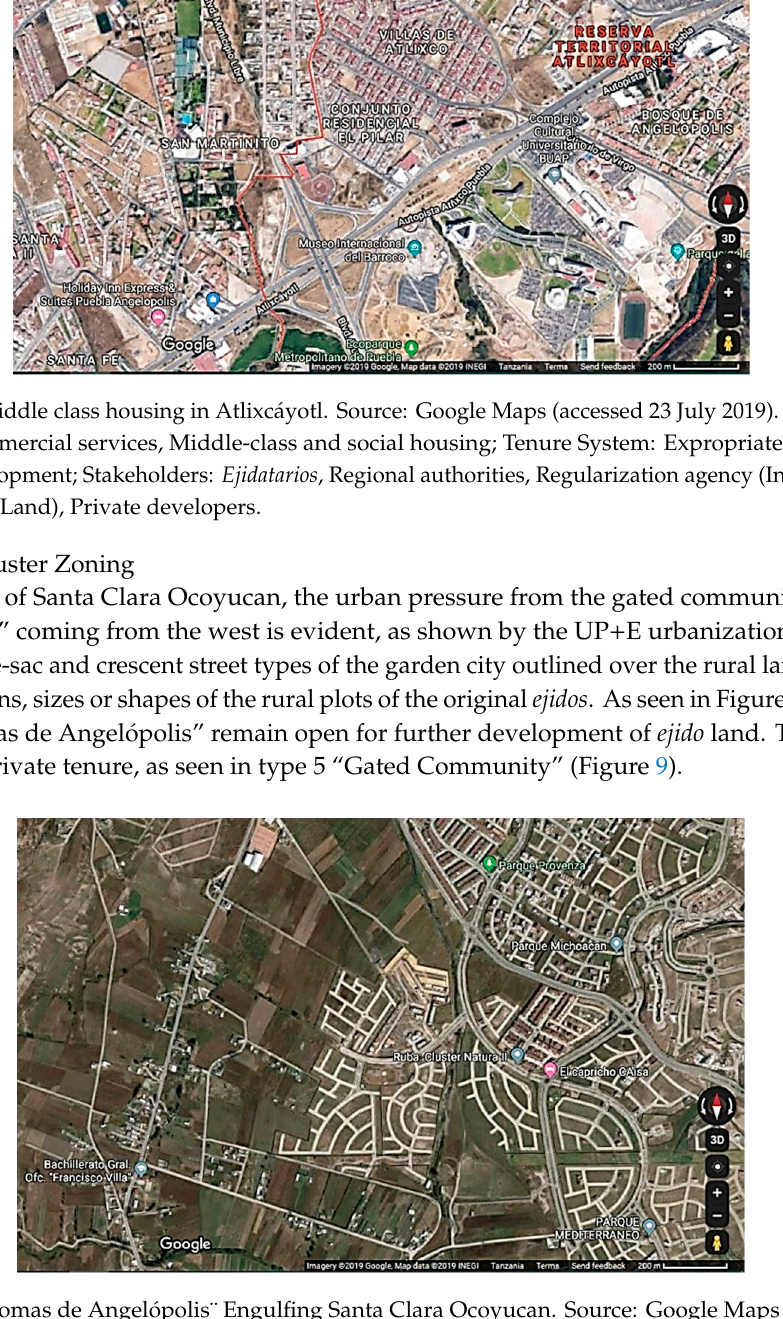
Figure 9. ¨Lomas de Angelópolis¨ Engulfing Santa Clara Ocoyucan. Source: Google Maps (accessed 23 July 2019). Land use: Gated community; Tenure System: Regularized ejido transformed into individual private ownership; Stakeholders: Ejidatarios , Landowners, Regularization agency (Institute for Sustainable Land), Private developers.